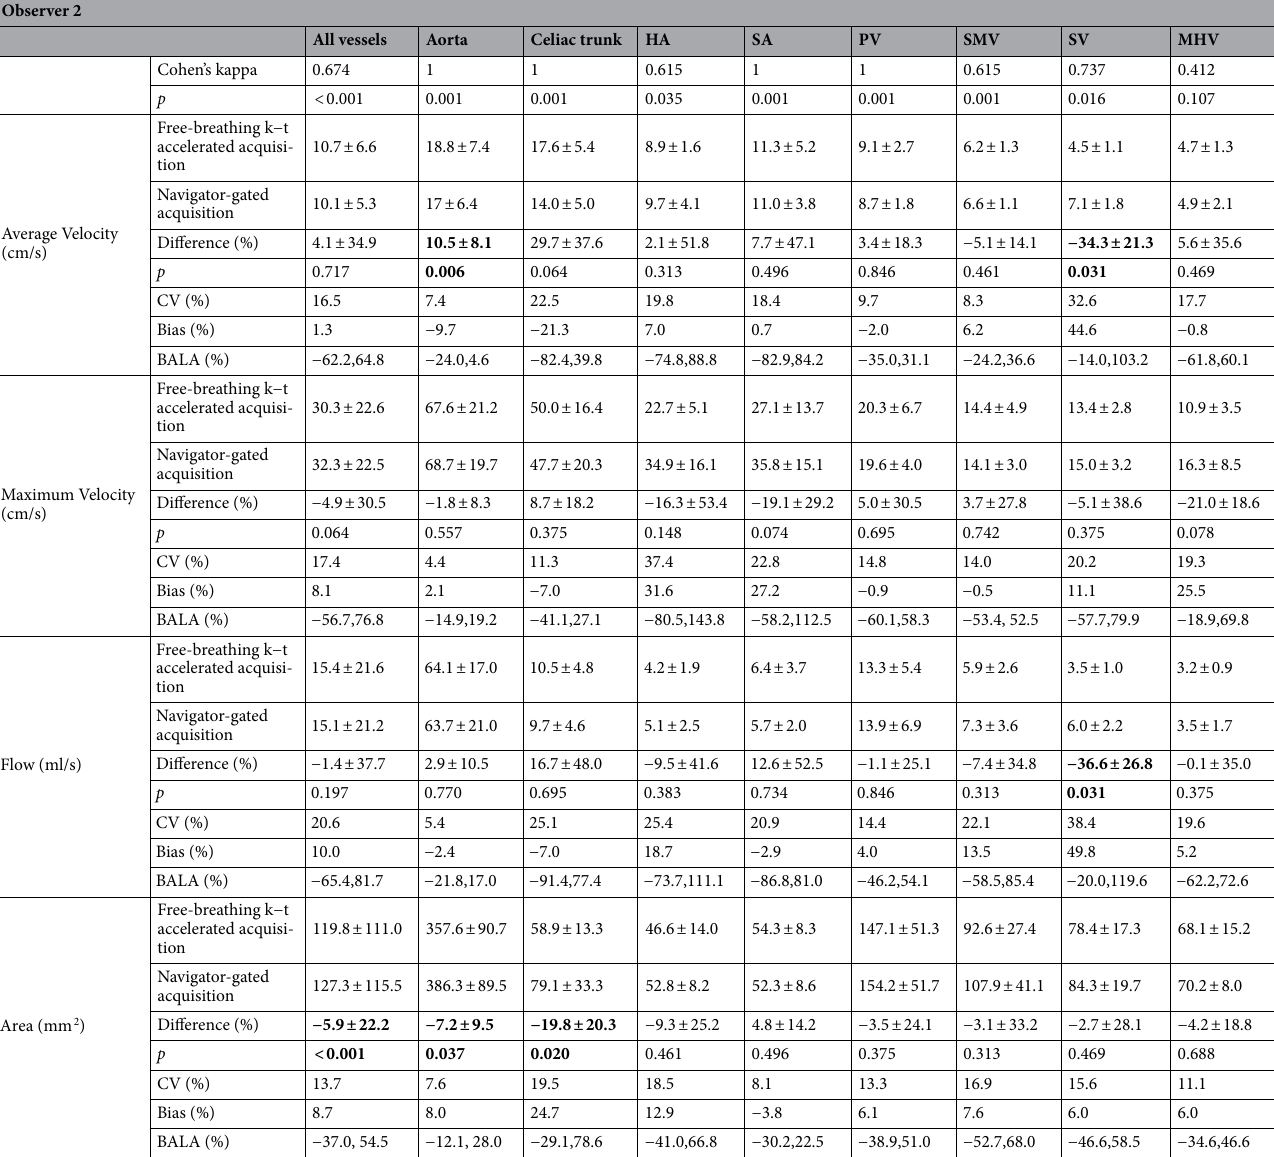
Table 4. Inter-sequence agreement in vessel identification and hemodynamic parameters measured by observer 2 on the free breathing k−t accelerated and the standard Cartesian navigator-gated acquisitions in abdominal vessels, along with intersequence differences in parameters. Agreement in vessel identification between acquisitions is measured by Cohen’s kappa. Mean and standard deviation of hemodynamic measurements with each acquisition are given for all vessels and for each individual vessel. Significant differences (paired Wilcoxon p < 0.05) in hemodynamic acquisitions are shown in bold font. Percent difference between the k−t no respiratory gating and the navigator-gated acquisition was calculated in vessels identified by both sequences as: Difference (%) = 100 x (k−t Measurement-Gated Measurement)/ Gated Measurement. Intersequence agreement of hemodynamic parameters is measured by inter-patient mean coefficient of variation (mean CV (%) = 100 SD/mean), Bland–Altman bias, and Bland–Altman limits of agreement (BALA). HA hepatic artery;, MHV middle hepatic vein, PV portal vein, SA splenic artery, SMV superior mesenteric vein, SV splenic